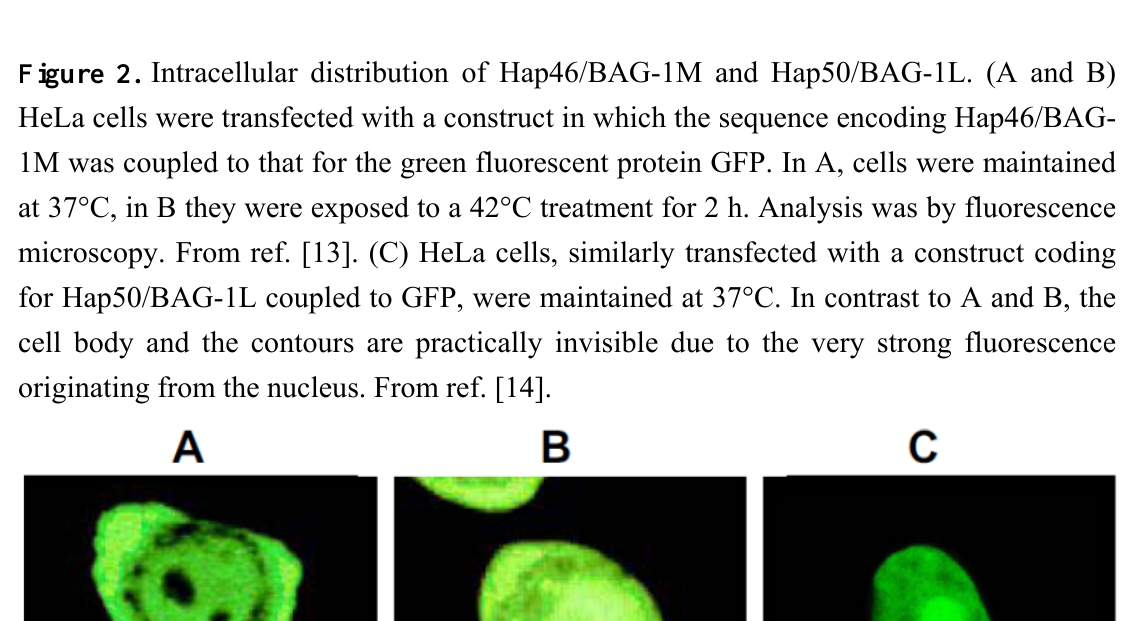
Figure 2. Intracellular distribution of Hap46/BAG-1M and Hap50/BAG-1L. (A and